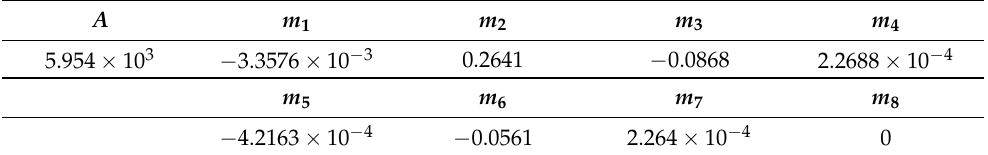
Table 4. Parameter values of the Hansel–Spittel flow law for the medium carbon steel.